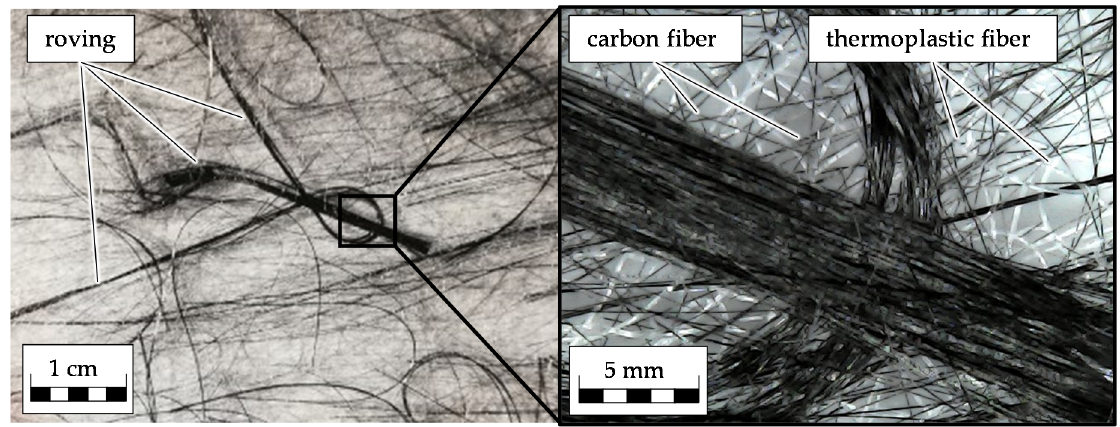
Figure 3. Schematic representation of the carding machine and sampling positions [30].